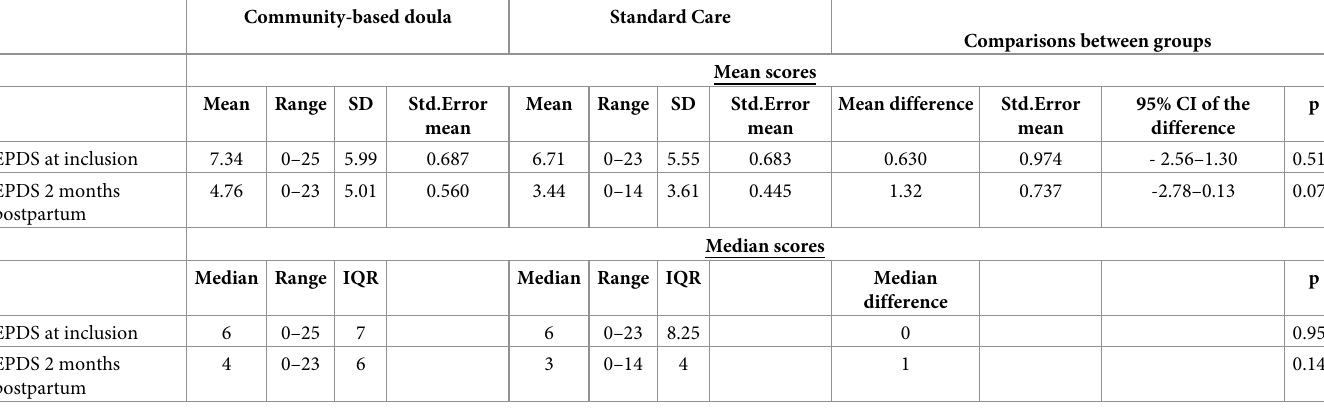
Table 2. Women’s wellbeing measured by the EPDS; mean scores (as in protocol) and median scores (due to highly scewed results). Community-based doula Standard